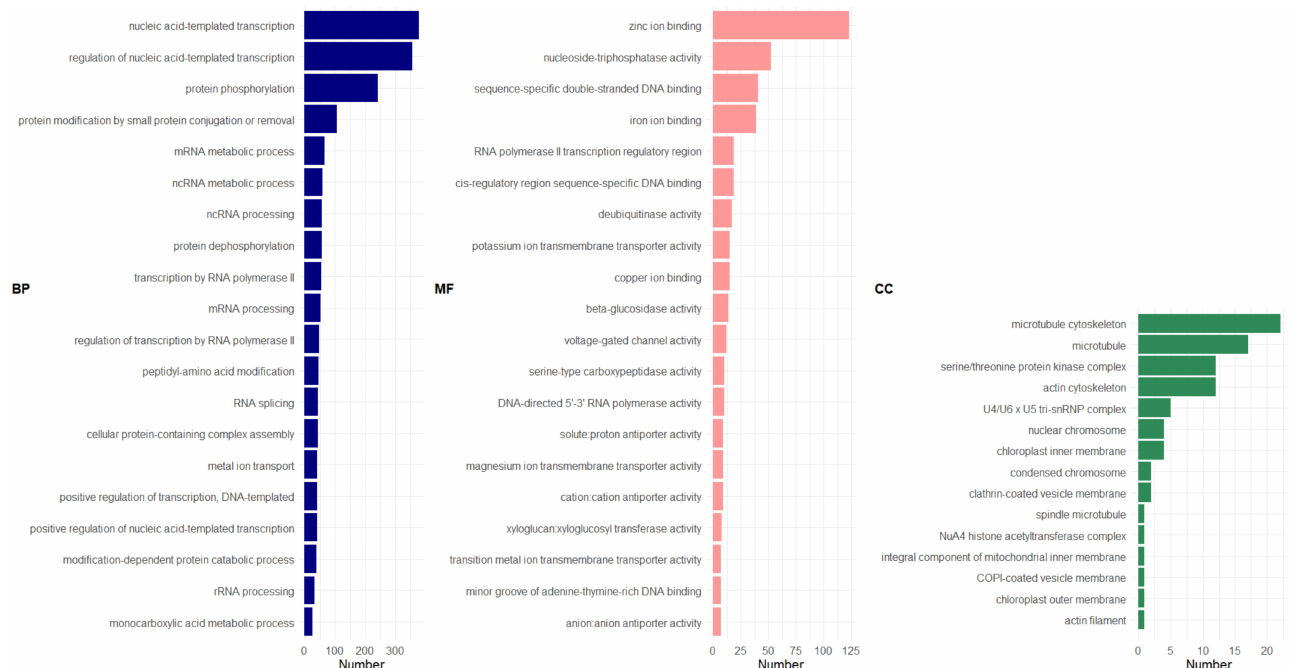
Figure 8. GO distribution of genes up-regulated in the abaca varieties using the NDE model for FQ across all abaca. Legend similar to Figure 6. Figure generated using ggplot2 [57] in Rstudio [21]. GO distribution analyzed using OmicsBox